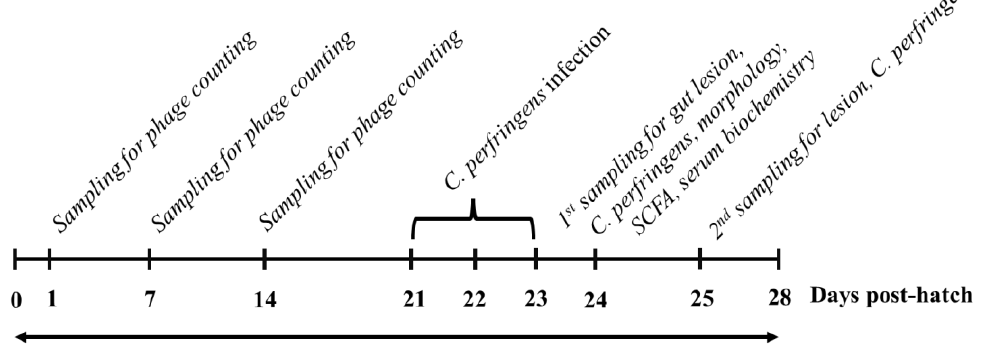
Figure 1. Experimental scheme. Broiler chicks were fed a control or bacteriophage (BP)-added diet for 28 d. On d 21, 22, and 23, half of the control group and BP-added diet-fed groups were orally inoculated with Clostridium perfringens . On d 1, 7, and 14, one bird per group ( n = 8/group) was randomly sampled for BP isolation in gut digesta. On d 1 post C. perfringens challenge, one bird per group ( n = 8/group) was sampled for gut lesion, C. perfringens counts, ileal morphology, cecal short-chain fatty acid (SCFA) contents, and serum biochemistry. On d 2 post C. perfringens challenge, one bird per group ( n = 8/group) was sampled for gut lesion and C. perfringens counts.